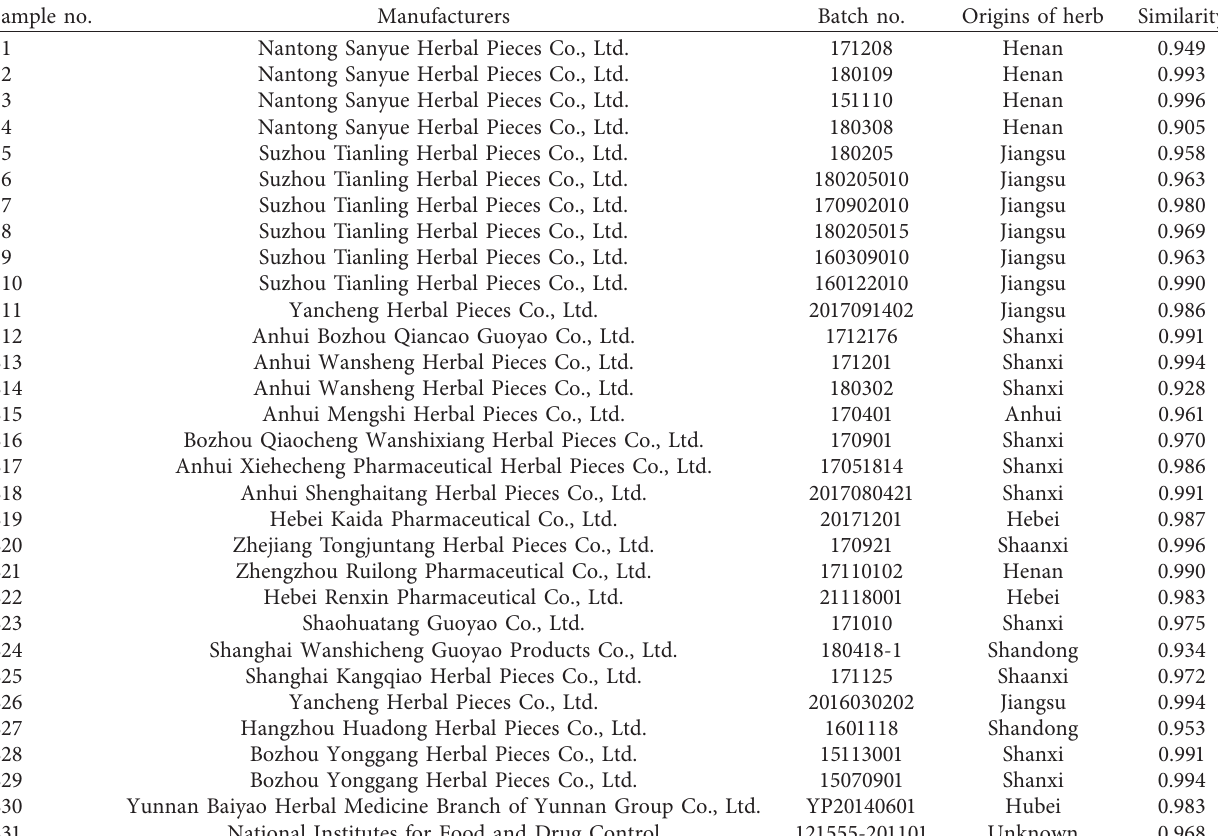
Table 1: Samples information and similarities.